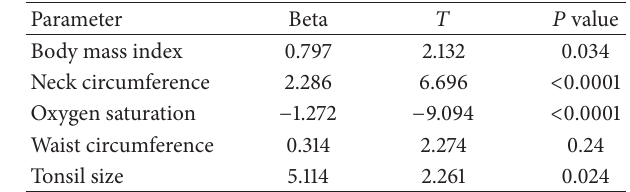
Table 3: Parameters used to identify independent predictors of apnea-hypopnea